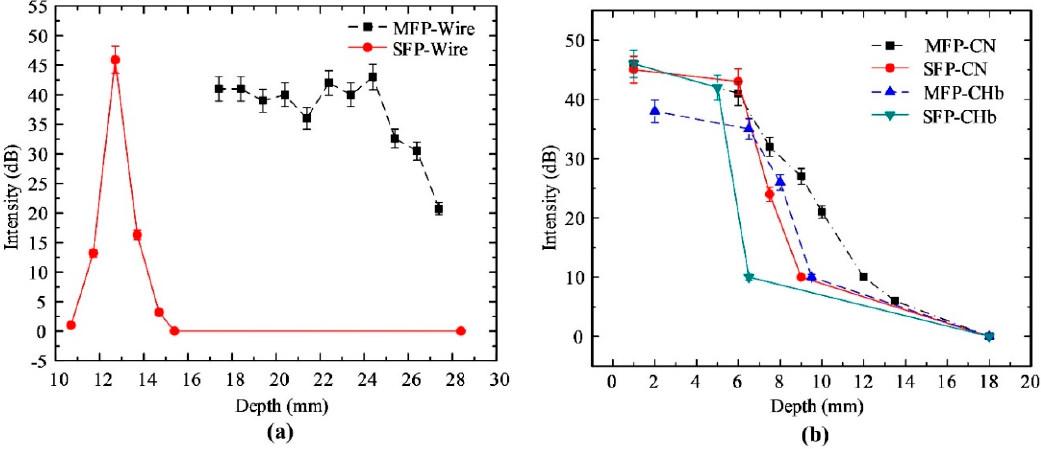
Figure 17. Target intensity versus depth for log-compressed ( a ) ultrasound images in the wire phantom and ( b ) photoacoustic images in the CN phantom and CHb phantom of the SFP (solid line) and MFP (dashed line) transducers. Error bars denote 95% confidence.